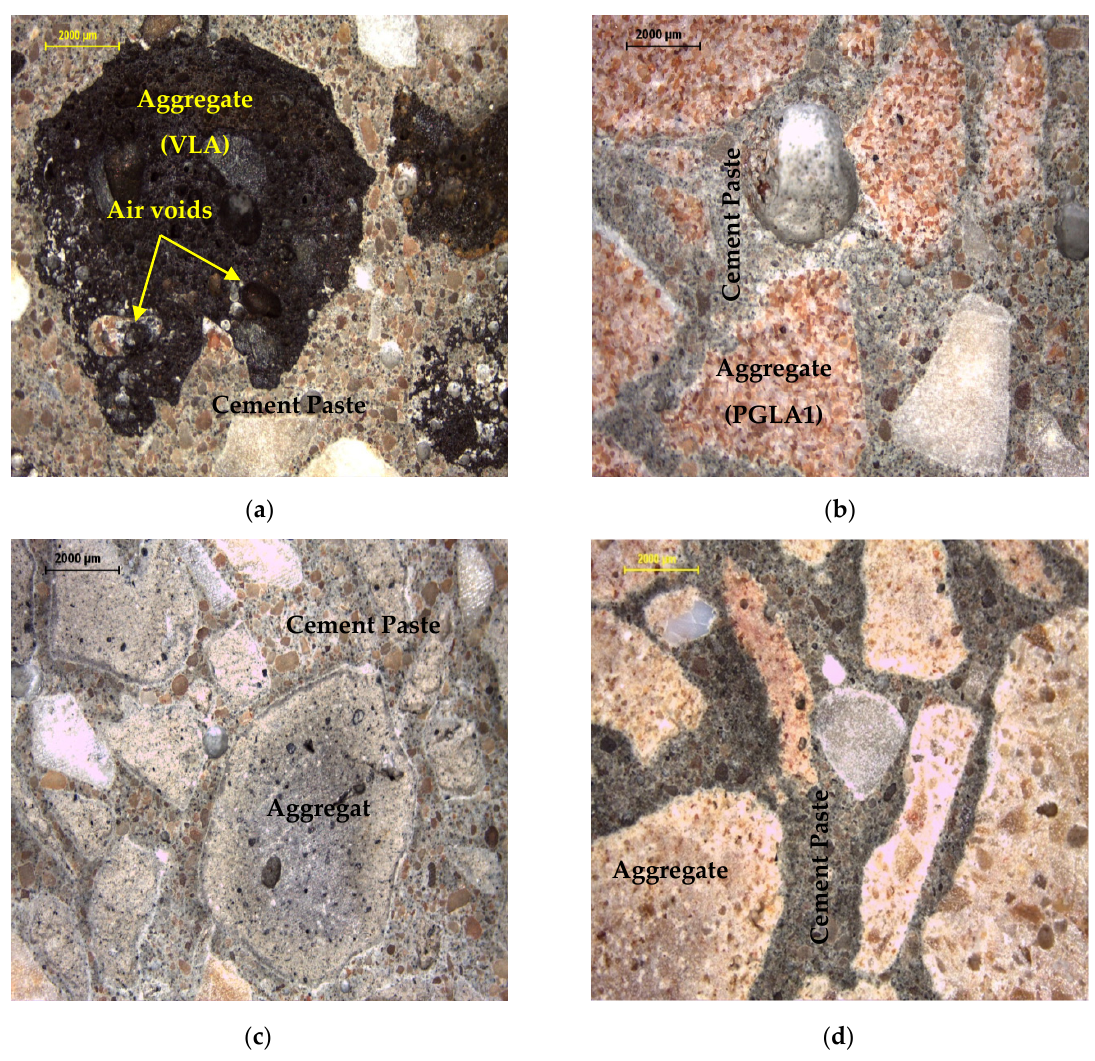
Figure 15. Optical microscopic images of ( a ) VLAC, ( b ) GLAC1, ( c ) GLAC2 and ( d ) GLAC3 (28 days).